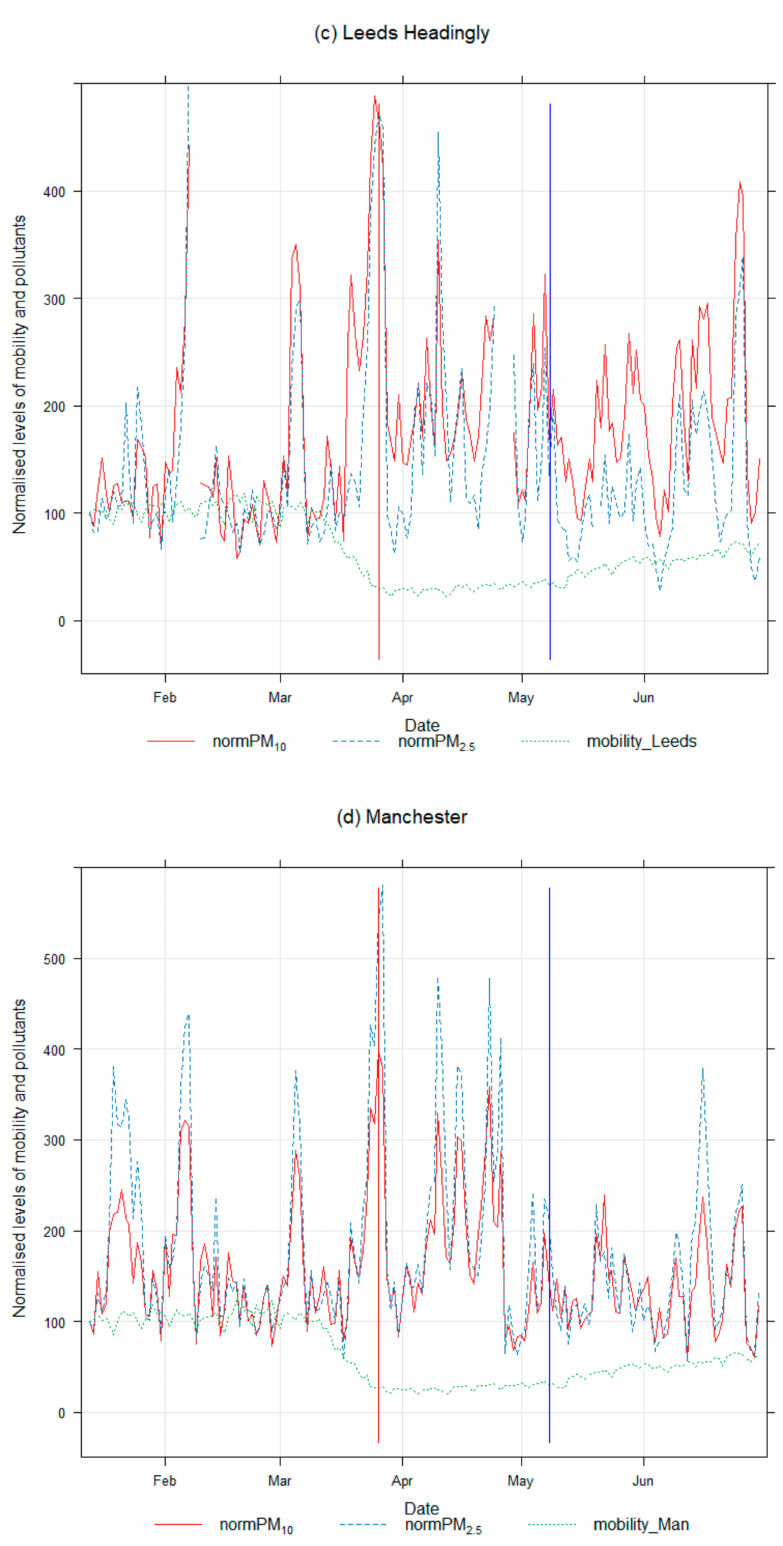
Figure 10. Time series plots between daily mean (%) mobility data and PM 2.5 and PM 10 at all AQMS. January 13 is taken as the baseline for normalisation. Vertical red and blue lines show the start and end of the lockdown period, respectively. ( a ) Sheffield Barnsley; ( b ) Sheffield Devonshire Green; ( c ) Leeds Headingley and ( d )